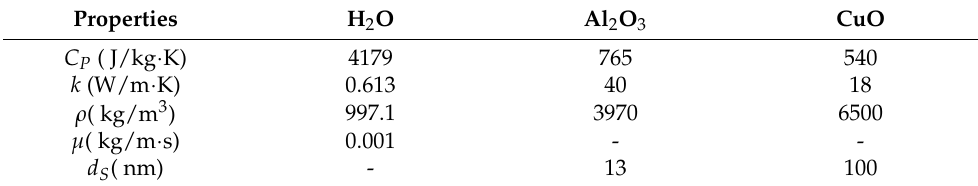
Table 1. Thermophysical properties of water, Al 2 O 3 and CuO NP [40–42].